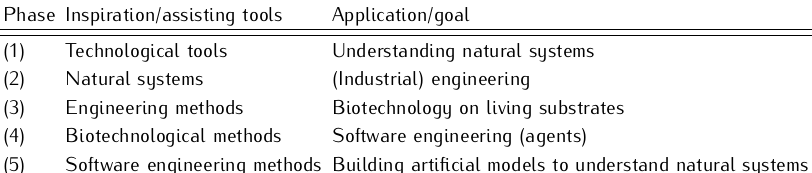
Table 2. Engineering and natural systems.